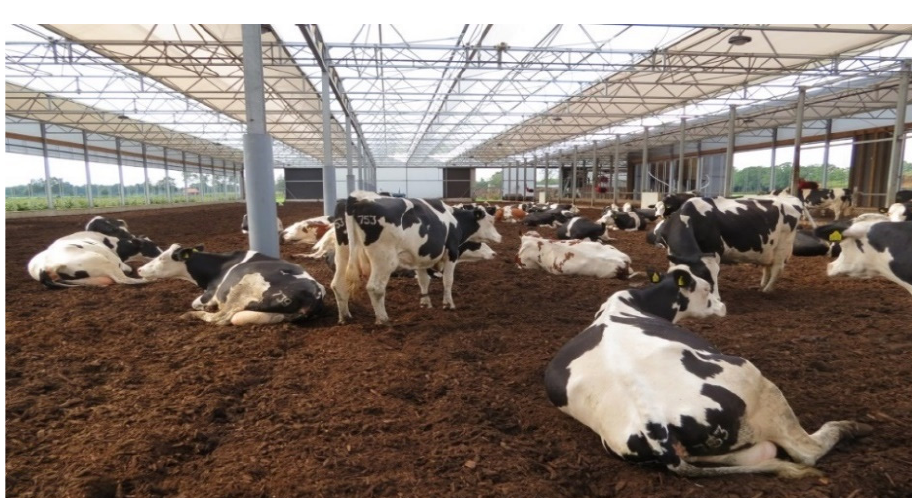
Figure 2. Compost bedded-pack (CBP) barn for dairy cows.